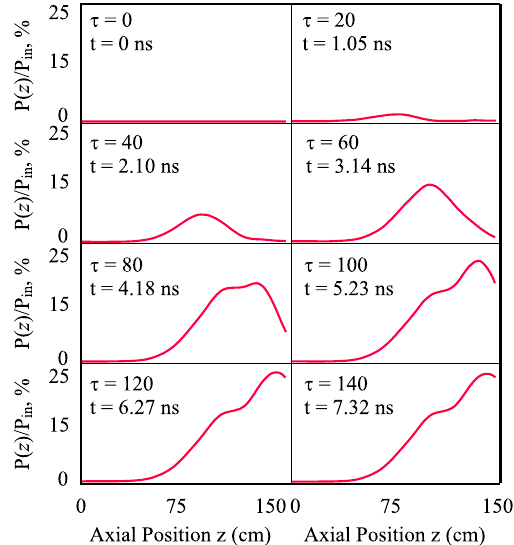
FIG. 11. Some electrons’ trajectories in the x - z and y - z planes are